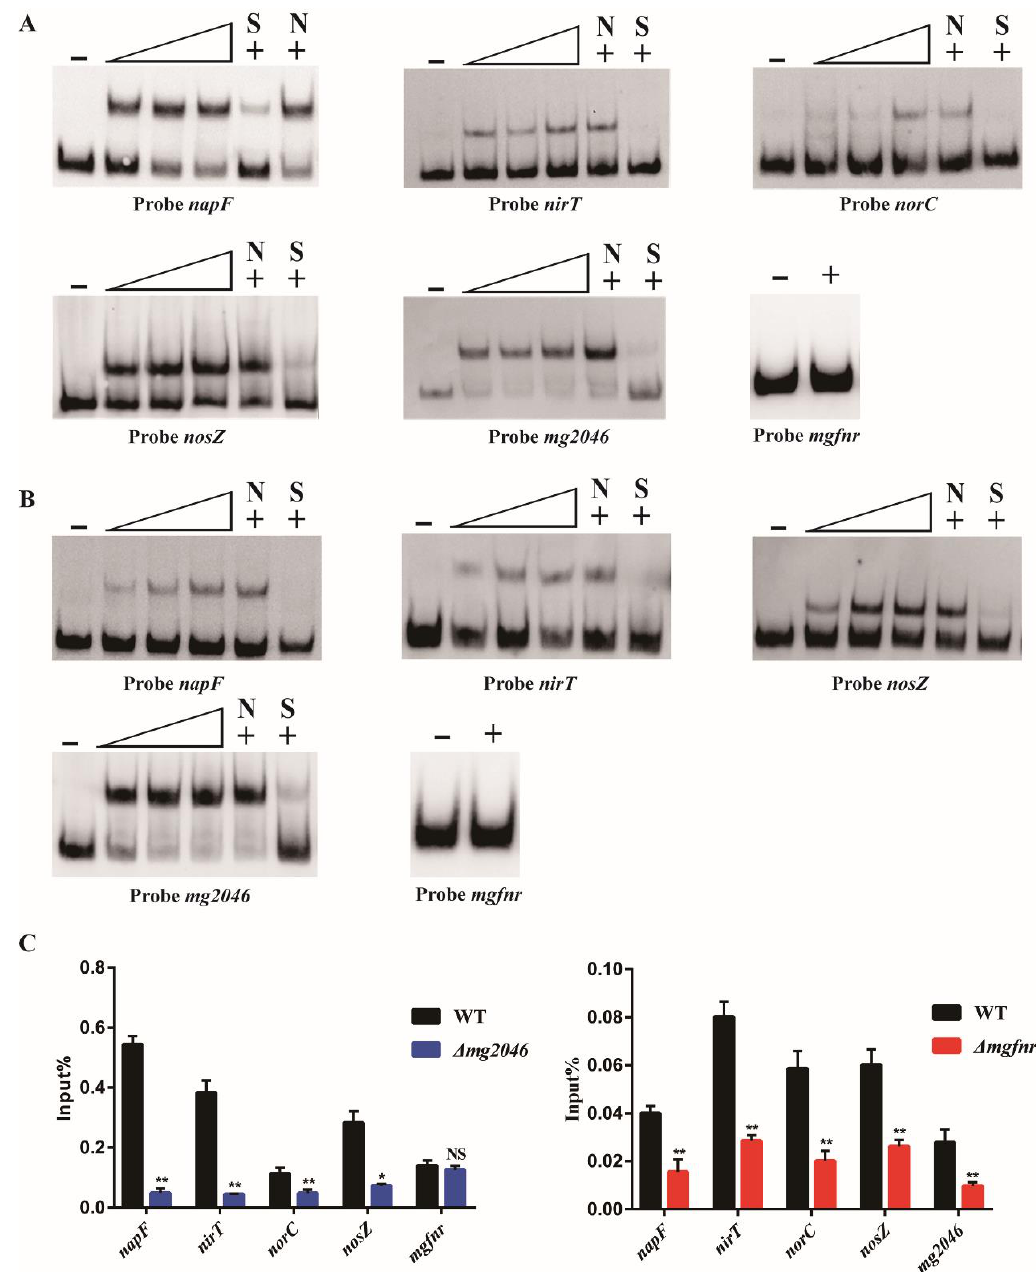
Figure 1. Mg2046 and Mgfnr combine with promoter regions of dissimilatory denitrification genes. ( A ) Mg2046 binds to promoter regions of napF , nirT , norC , nosZ , and mg2046 . Each lane contains 0.4 nM of labeled probe. Lanes 1–6 respectively contain 0, 20, 40, 60, 60, and 60 ng of His 6 -Mg2046. Lanes 5 and 6 are added with 100-fold unlabeled nonspecific competitor DNA (N) or unlabeled specific probe (S) to confirm binding specificity. ( B ) Mgfnr binds to promoter regions of napF , nirT , nosZ , and mg2046 . Lanes 1–6 contain 0, 40, 80, 120, 120, and 120 ng of His 6 -Mgfnr. ( C ) In vivo ChIP-qPCR analysis. MSR-1 strains WT, ∆ mg2046 , and ∆ mgfnr were immunized with anti-Mg2046 and -Mgfnr antibodies for 24 h. y-axis: relative abundance of mg2046 and mgfnr for each point. NS: no significant difference ( t -test). * p < 0.05; ** p < 0.01. Error bar: SD from three replicate